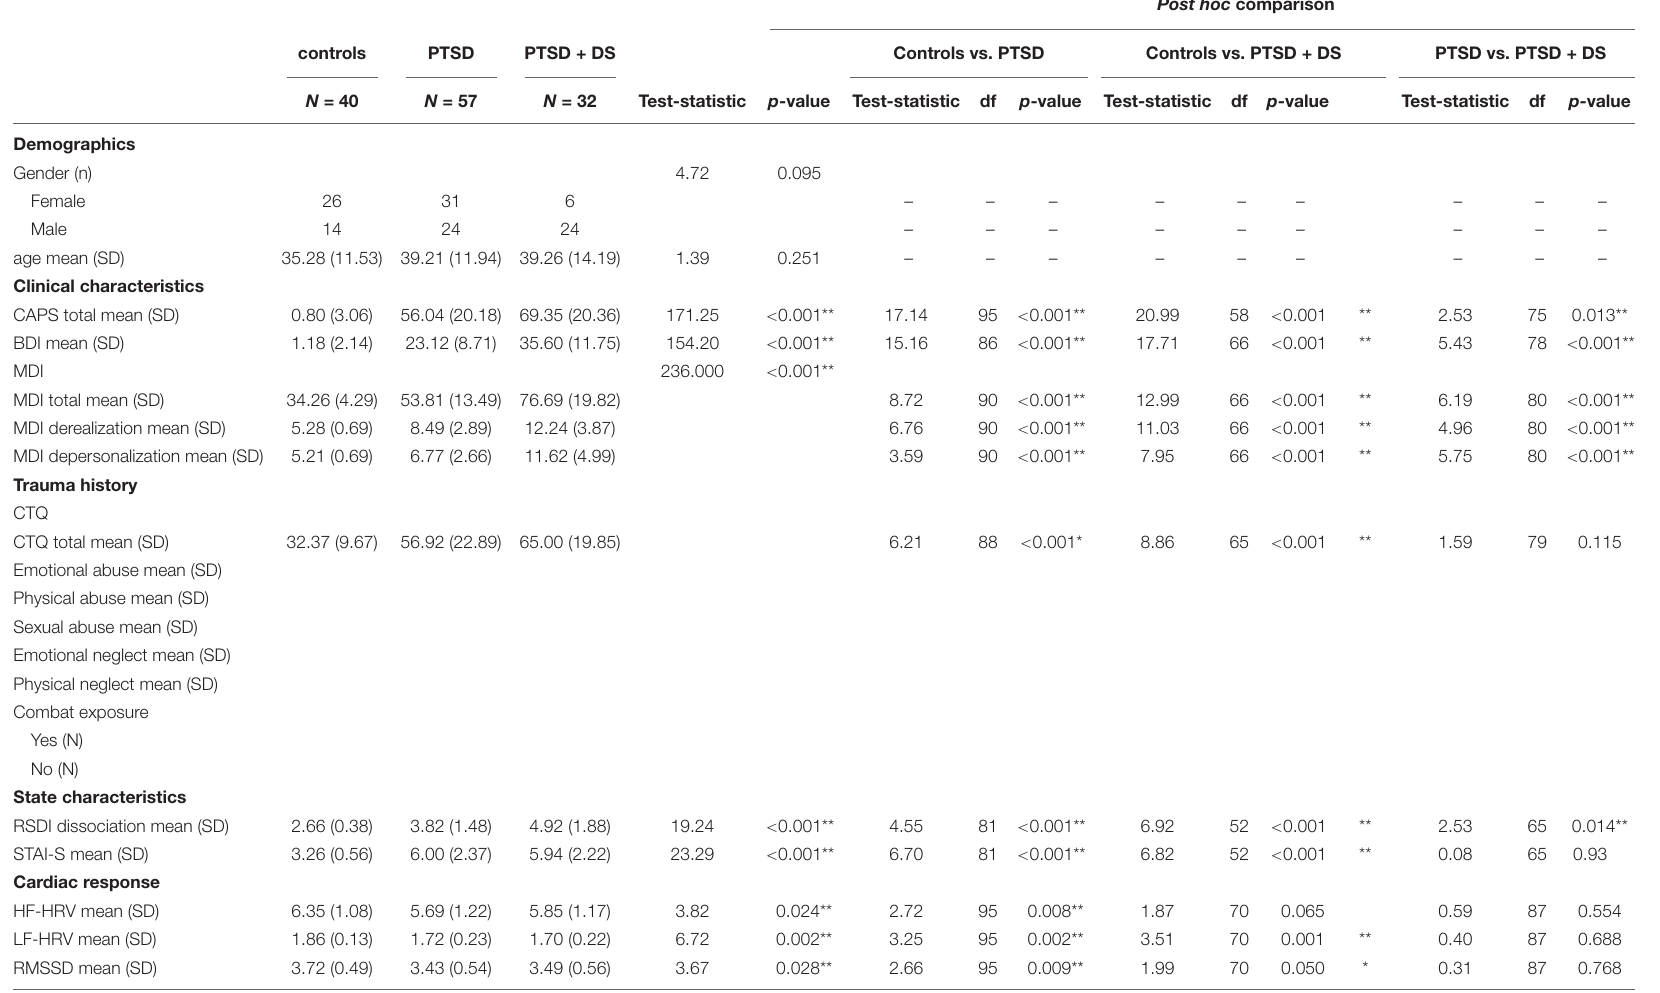
TABLE 1 | Demographic and clinical characteristics of the study